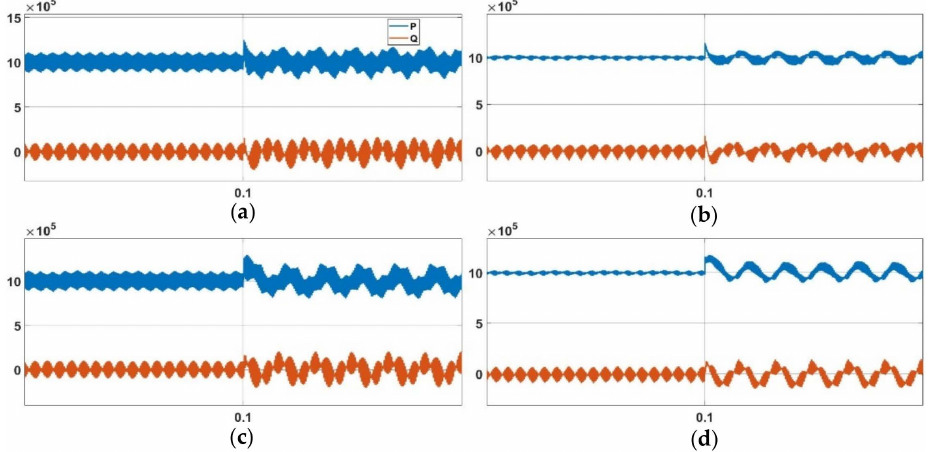
Figure 27. Power flow in an unbalanced voltage swell in the case of ( a ) 2L- αβ , ( b ) 3L- αβ , ( c ) 2L-dq and ( d ) 3L-dq.